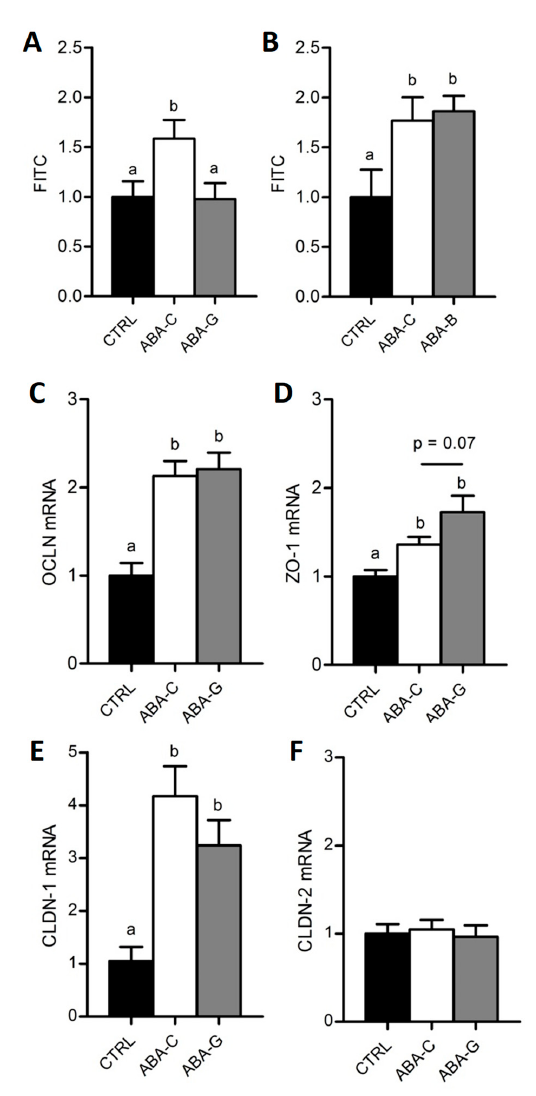
Figure 3. Colonic permeability and tight junction protein mRNA. Colonic paracellular permeability was evaluated in Ussing chambers with FITC-Dextran (4 kDa) in both Gln ( A ) and BCAA ( B ) series. Colonic tight junction protein mRNA levels were only assessed for Gln by using RT-qPCR: OCLN ( C ), ZO-1 ( D ), CLDN-1 ( E ) and CLDN-2 ( F ). Column bar graphs showed control mice (CTRL; black bars), non-supplemented activity-based anorexia mice (ABA-C; open bars) and supplemented activity-based anorexia mice (ABA-G or ABA-B; grey bars). Values without a common letter significantly differ ( p < 0.05). The number of mice was n = 15 for CTRL, n = 15 for ABA-C and n = 12 for ABA-G ( A ), n = 8 for CTRL, n = 8 for ABA-C and n = 7 for ABA-B ( B ) and n = 16 for CTRL, n = 16 for ABA-C and n = 12 for ABA-G ( C, D, E, F ).